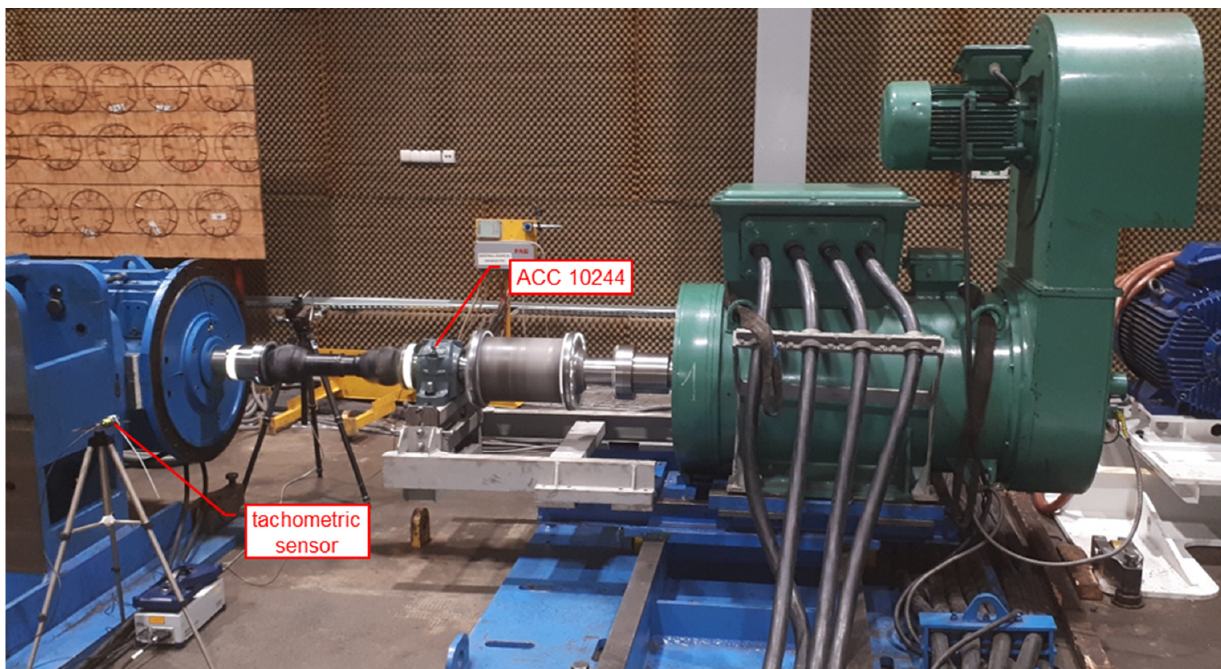
Figure 8. Location of the vibration and tachometric sensors used for the analytical experiment.